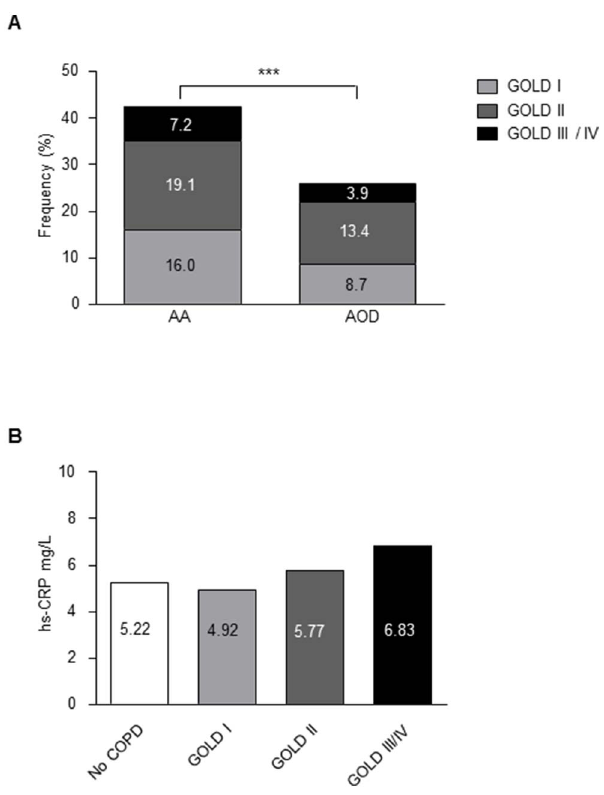
Figure 1. Prevalence and severity of COPD in patients with an aortic aneurysm (AA) or arterial occlusive disease (AOD). (A) The prevalence of COPD in all GOLD classes was higher in AA (n=614) compared to AOD patients (n=779, ***p , 0.001). (B) Serum high- sensitivity CRP levels according to severity of COPD in patients with AA or AOD. There was no significant difference between patients with and without COPD (p for trend=0.123).